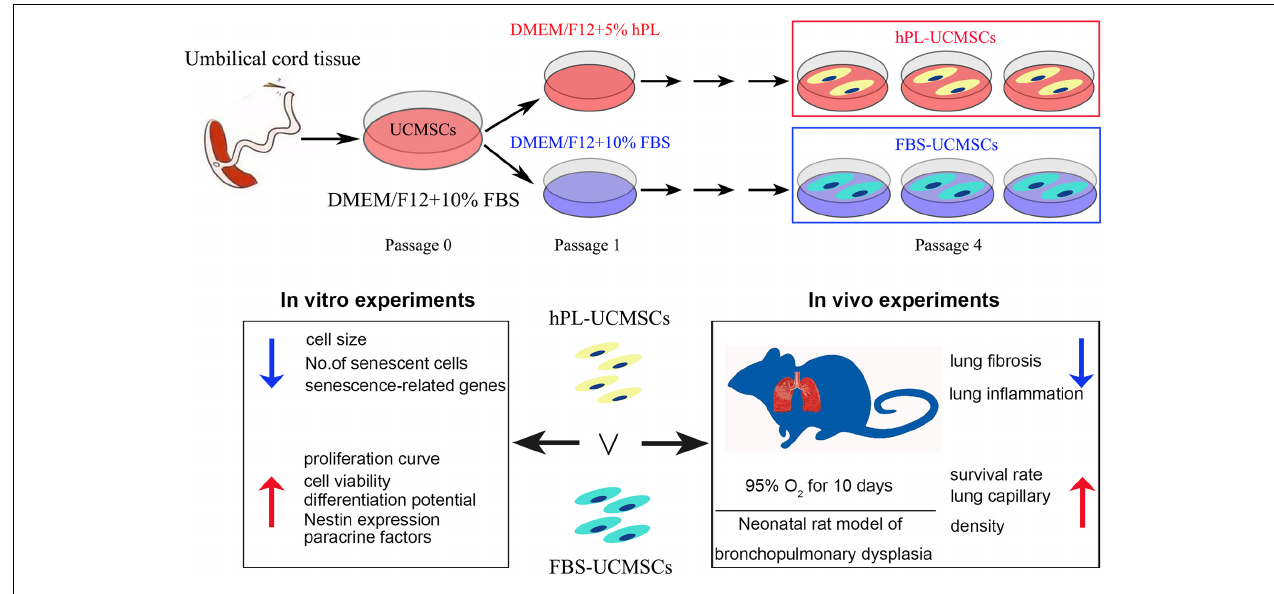
FIGURE 7 | The overview of the work (graphical